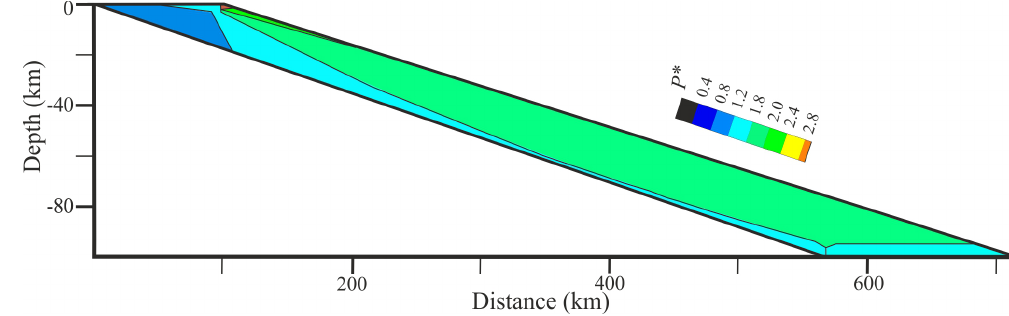
Figure A2. Overpressure in the UTC under the velocity field shown in Fig. 3.